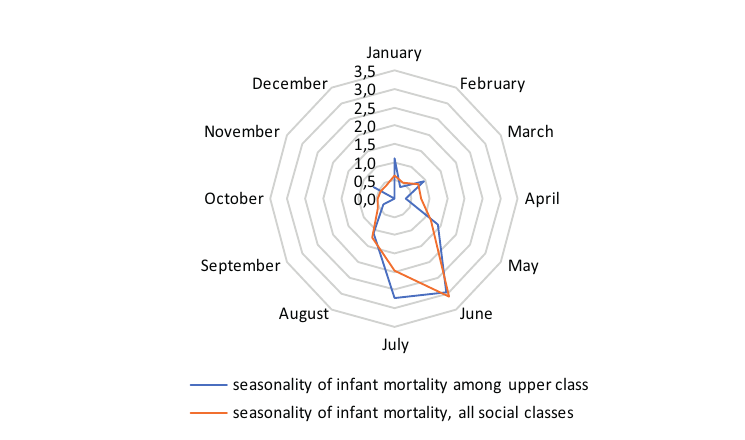
Figure 5. Seasonal indices of infant mortality in upper classes (nobles, officials, merchants) in the Pokrovsky parish, 1877-1897, both sexes. Source : author’s calculations based on parish registers Table 2. Leading causes of death among infants in the Pokrovsky parish, by social class, average for 1877-1897, both sexes, %